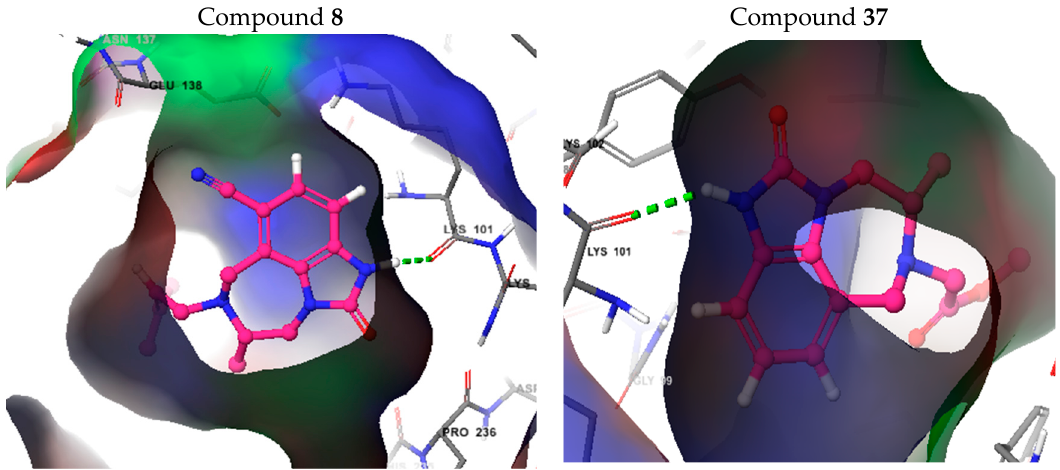
Figure 5. Hydrogen bond between the imidazolone ring of the ligand and the LYS101 residue of the RT. Hydrophobic, electrostatic, and steric contour maps are represented by green, blue, and red contours, respectively.